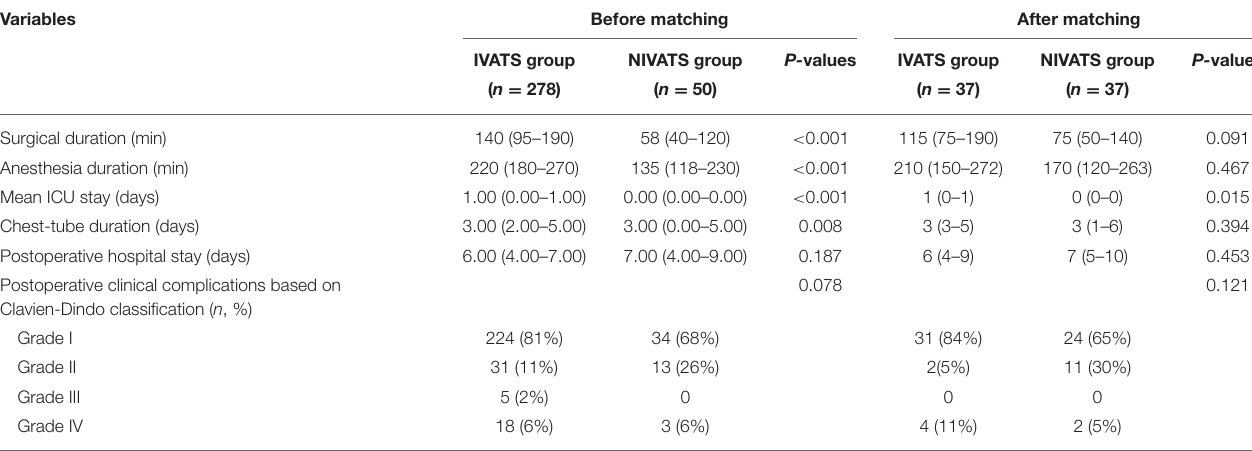
TABLE 2 | Comparison of intraoperative and postoperative variables.